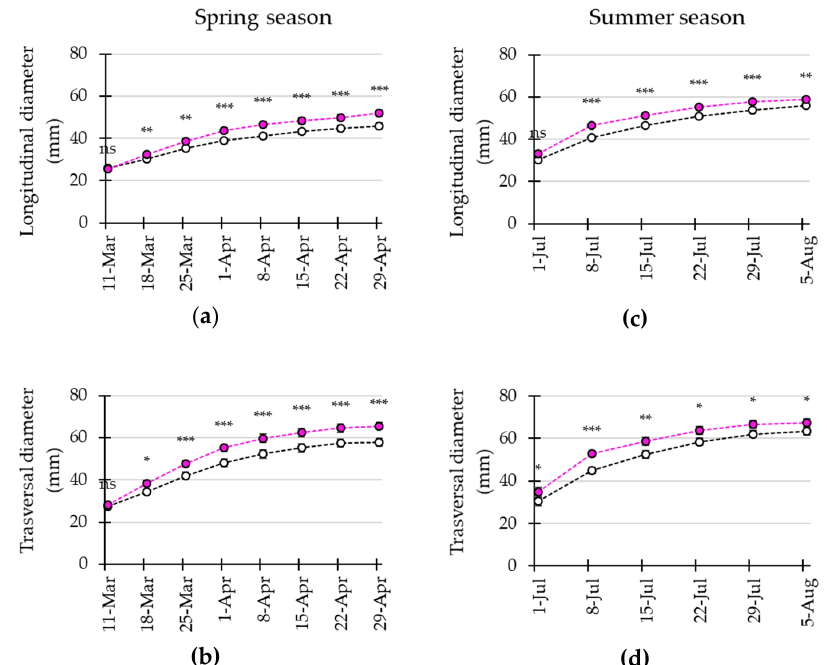
Figure 5. E ff ect of supplemental LED interlighting (pink) and control treatment (white) on longitudinal ( a , c ) and transversal diameter ( b , d ) during spring ( a , b ) and summer ( c , d ) season. Symbols (*) indicate significant di ff erences at p ≤ 0.05 (*), 0.01 (**), or 0.001 (***), “ns” indicates non-significant di ff erences at Figure 5. Effect of supplemental LED interlighting (pink) and control treatment (white) on p ≤ longitudinal ( a and c ) and transversal diameter ( b and d ) during spring ( a and b ) and summer ( c and d ) season. Symbols (*) indicate significant differences at p ≤ 0.05 (*), 0.01 (**), or 0.001 (***), “ns” indicates non ‐ significant differences at p ≤ 0.05.